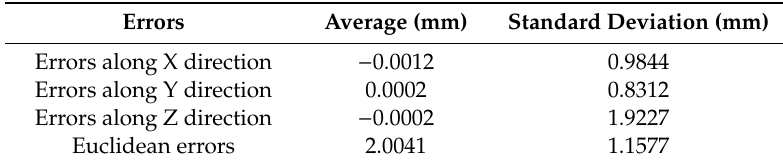
Figure 6. Histogram of Euclidean errors between the end effector coordinates and transformed coordinates of the 3D scanned positions. Table 1. Averages and standard deviations of the errors between the end effector coordinates and transformed coordinates of the 3D scanned positions.